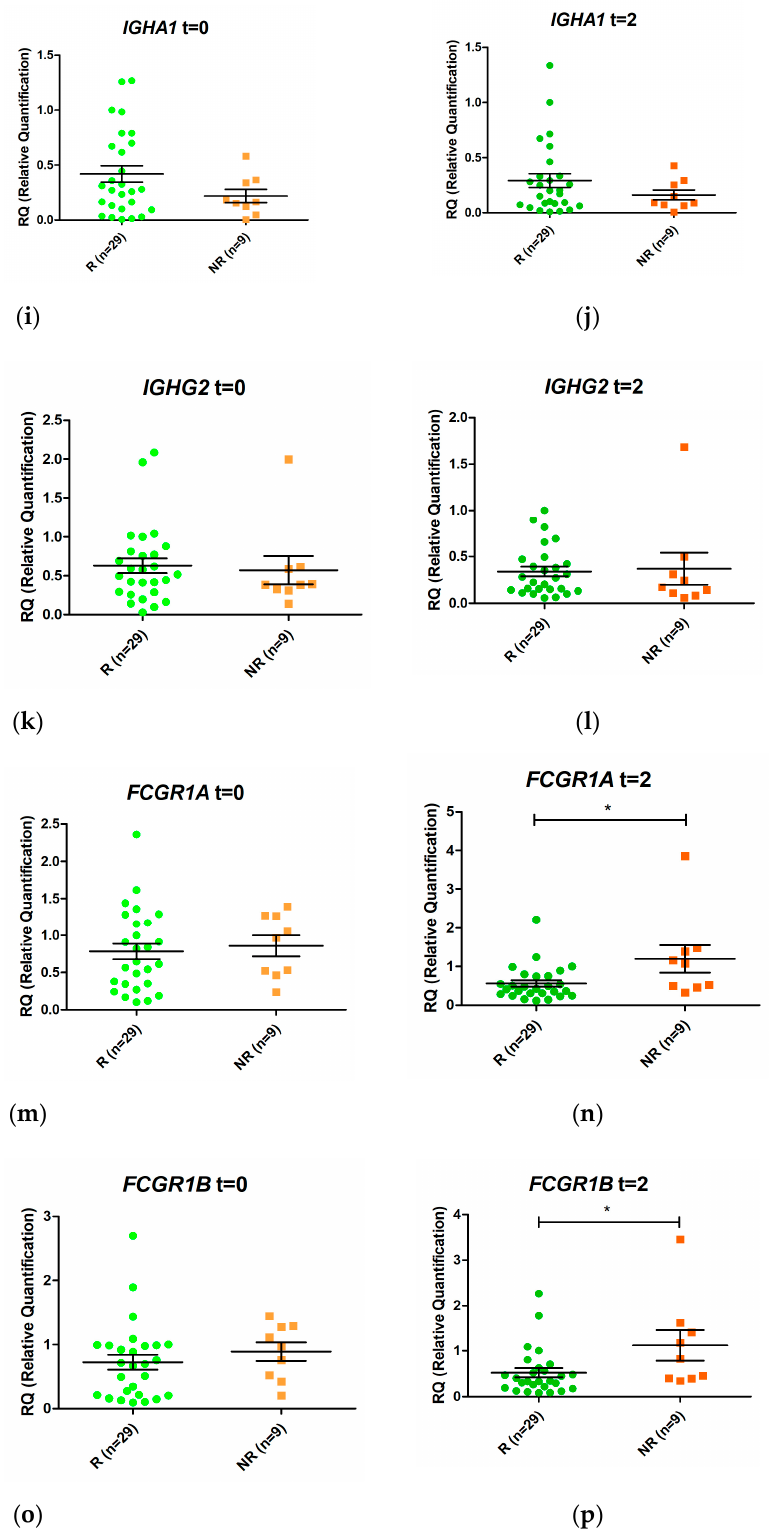
Figure 3. Relative expression levels of the genes GBP1 ( a , b ), GBP5 ( c , d ), GNLY ( e , f ), BATF2 ( g , h ), IGHA1 ( i , j ), IGHG2 ( k , l ), FCGR1A ( m , n ), and FCGR1B ( o , p ) in responders (R, green) and non-responders (NR, orange) at time 0 ( t = 0) and at two weeks ( t = 2) after initiation of anti-TNF therapy. Expression values were normalized to the ACTB and RPL4 genes. Values are expressed as mean (horizontal line) and standard error of the mean (SEM); n , sample size; * p value < 0.05 vs. control (unpaired t test).